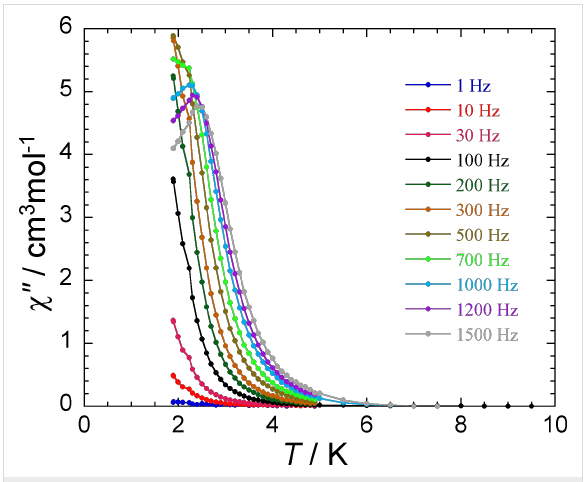
Figure 5: Plot of out-of-phase ac susceptibility signals vs temperature for 1 at the indicated oscillation